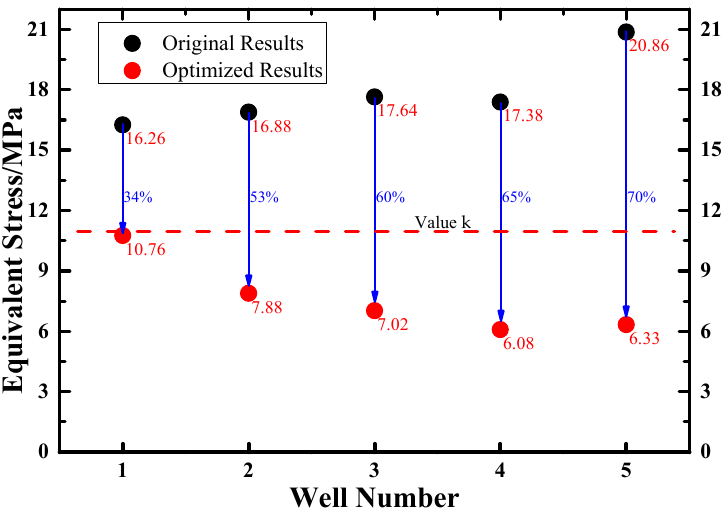
Figure 16. Equivalent stress of the cement sheath in original and optimized parameters.